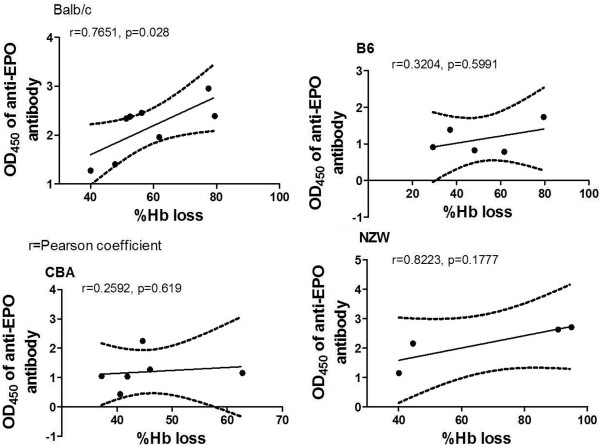
Correlation between %Hb loss and anti-EPO antibody (per mice strains). Total number of samples n = 23 (Balb/c (8), B6 (5), CBA (6), NZW (4)). Dotted lines are 95% confidence intervals and the continuous line is the line of best fit. r is Pearson coefficient. Blood was harvested at minimum Hb in the course of monitoring the haematological and parasitological parameters. These are values of two separate experiments.